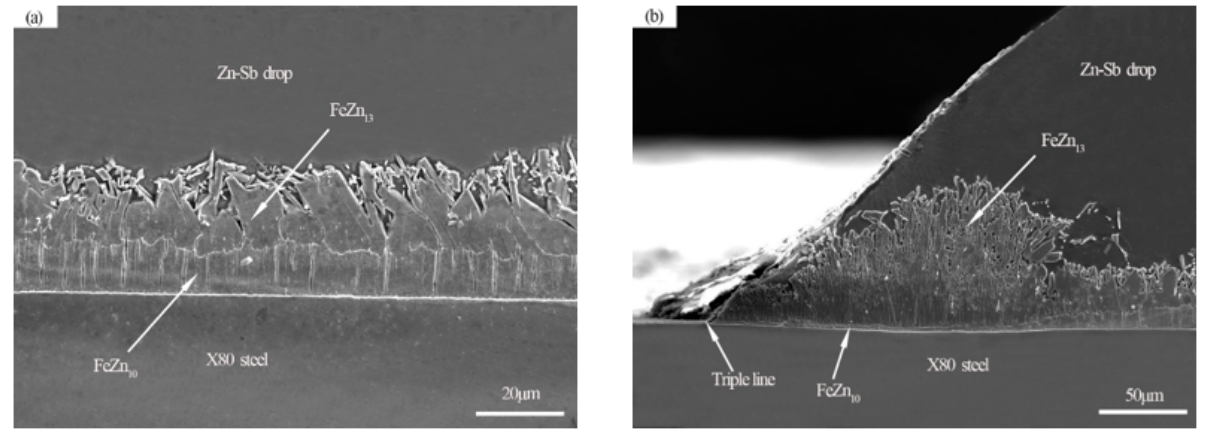
Figure 5. Micro-morphology of interface reaction layer of Zn-1.0 wt. % Sb/X80 steel: ( a ) central reaction layer; ( b ) triple line reaction layer.